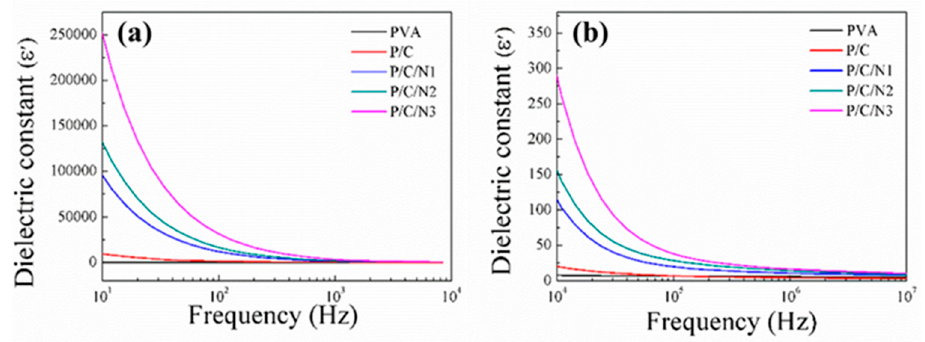
Figure 5. The dielectric constants of the obtained composite films at ( a ) low frequency and ( b ) high frequency.